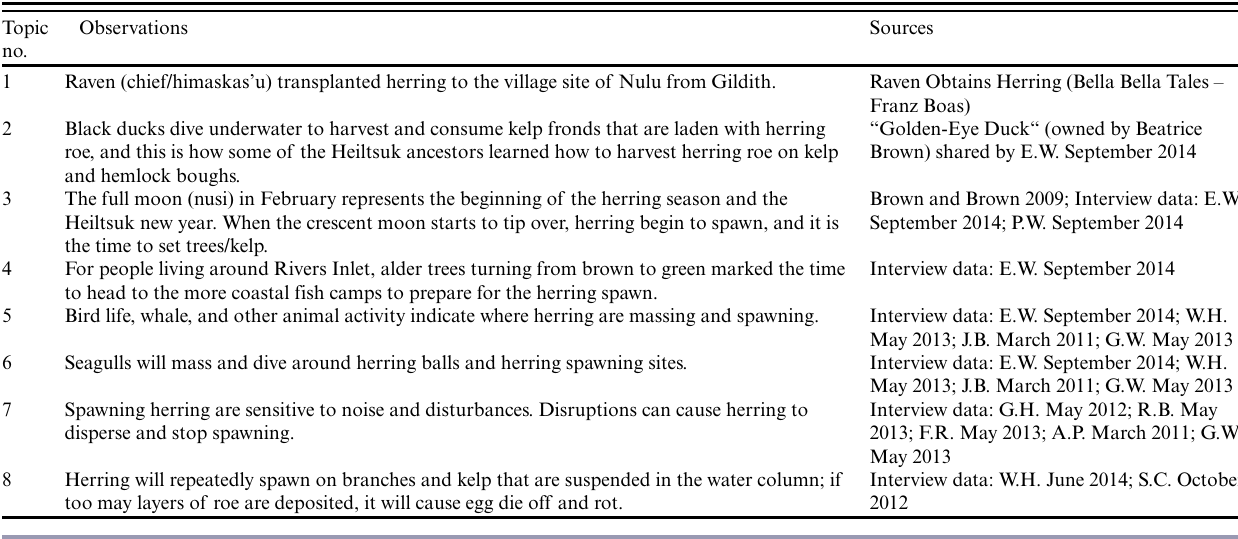
Table 1 . Deep-time traditional ecological knowledge of Pacific